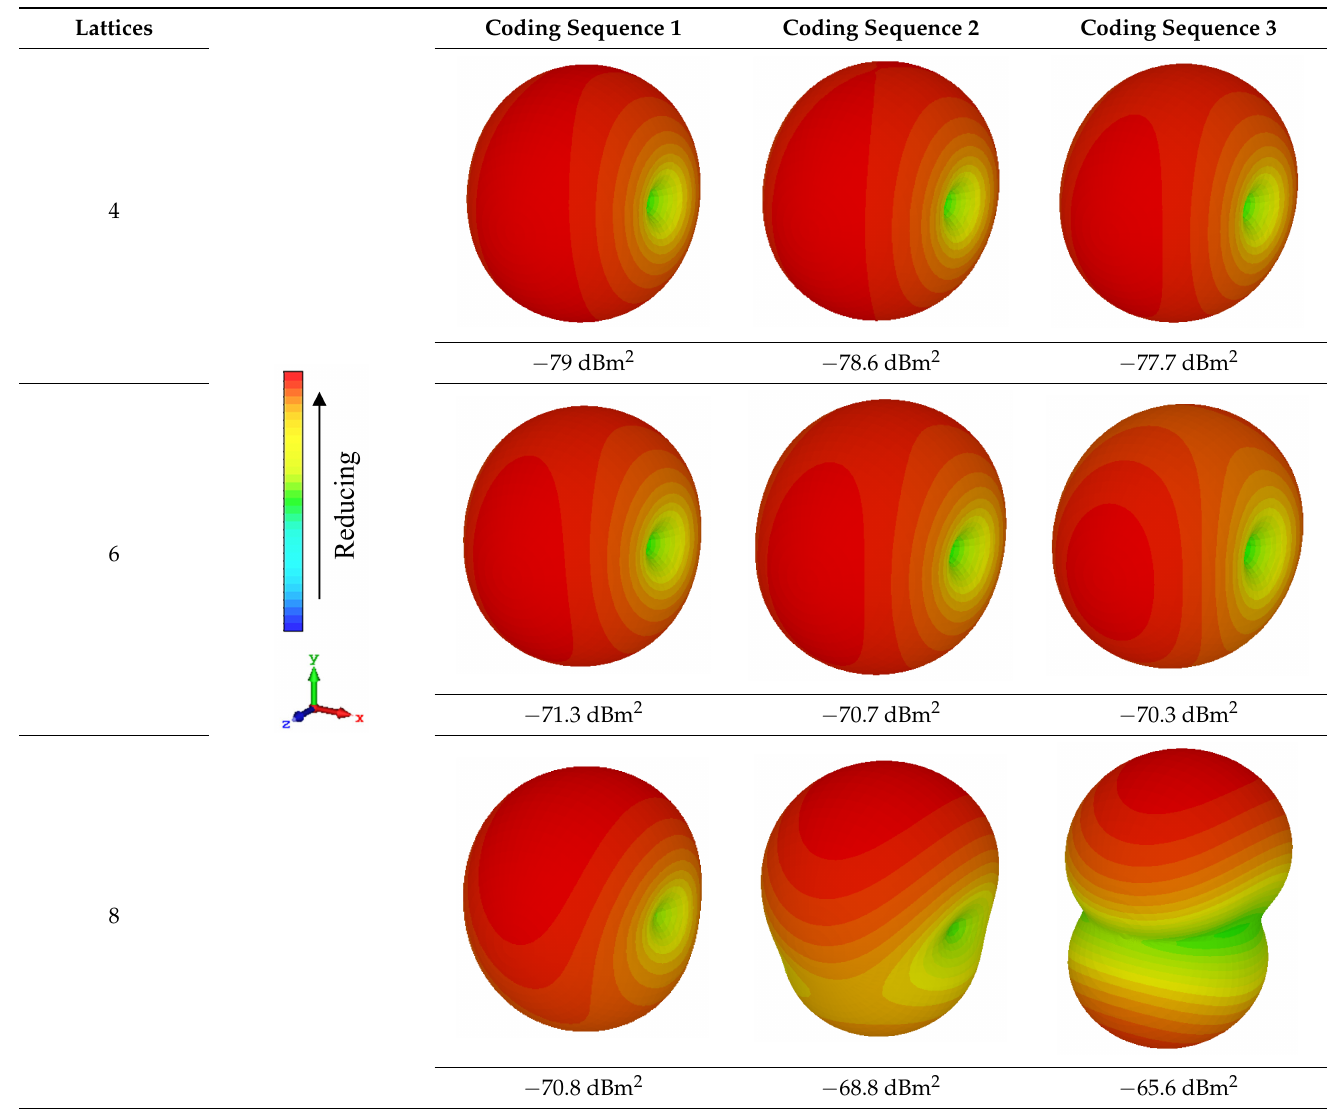
Table 3. Bistatic RCS scattering patterns of three types of lattices at 0.84